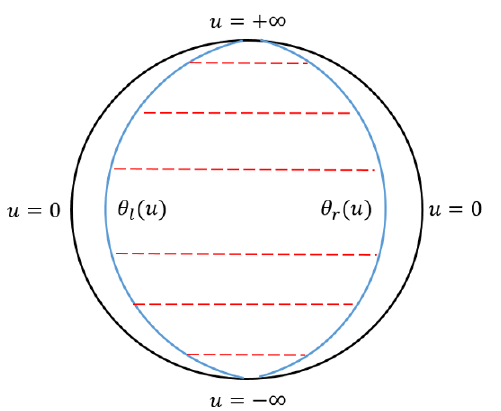
Figure 2 . In Euclidean signature, the e(cid:11)ective action can be expressed using angular coordinate of a Hyperbolic disk. In the (cid:12)gure, the blue lines represent the two boundary trajectories, and the red dashed lines denote the coupling between